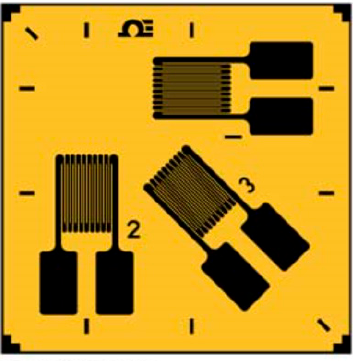
Figure 6. Three-directional strain sensor.